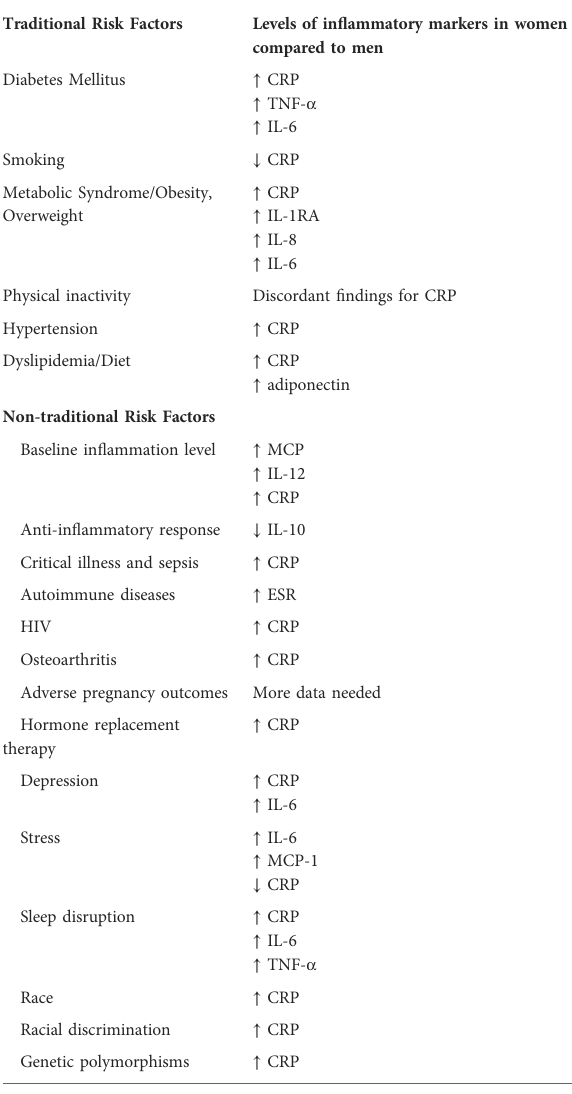
TABLE 1 Female-speci fi c in fl ammatory conditions that predispose to CVD. Traditional Risk Factors Levels of in fl ammatory markers in women compared to